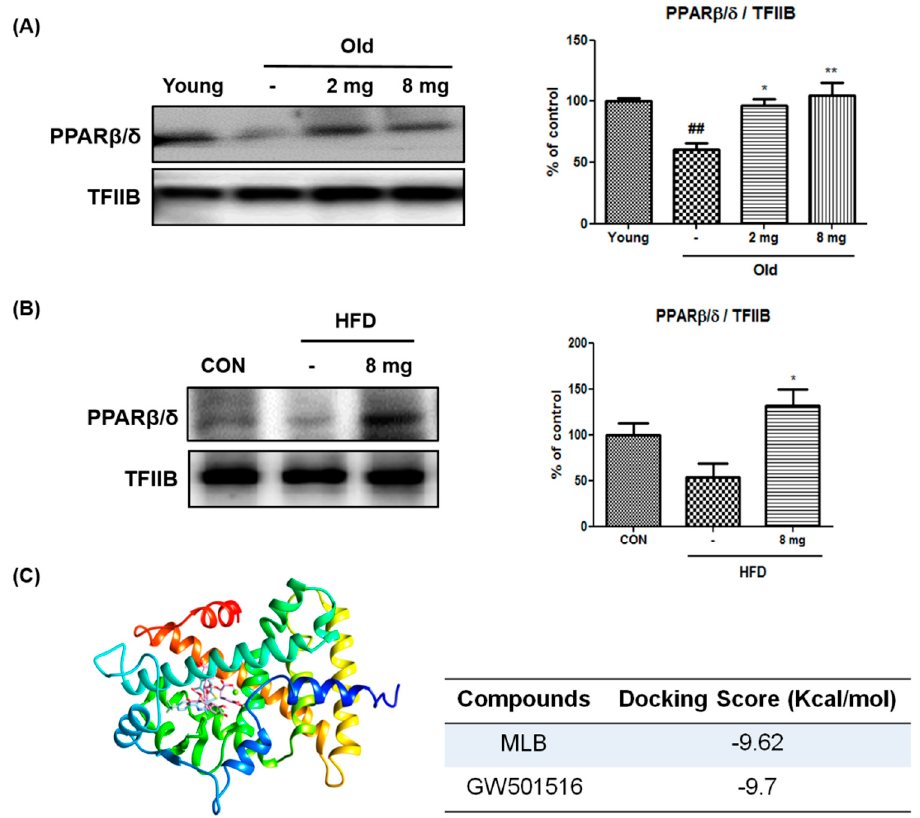
Figure 1. Effect of MLB on PPAR β / δ activation. ( A , B ) The level of PPAR β / δ was analyzed by western blotting ( n = 4 per group). The nucleus protein level of PPAR β / δ was normalized by transcription factor II B (TFIIB). Data represents the mean ± S.E.M. Statistical results of one-way analysis of variance (ANOVA): ## p < 0.01 versus the young rats, * p < 0.05, ** p < 0.01 versus the MLB-untreated aged rats and HFD-fed mice. 2 mg, MLB 2 mg/kg/day; 8 mg, MLB 8 mg/kg/day; HFD, high-fat diet-fed mice.